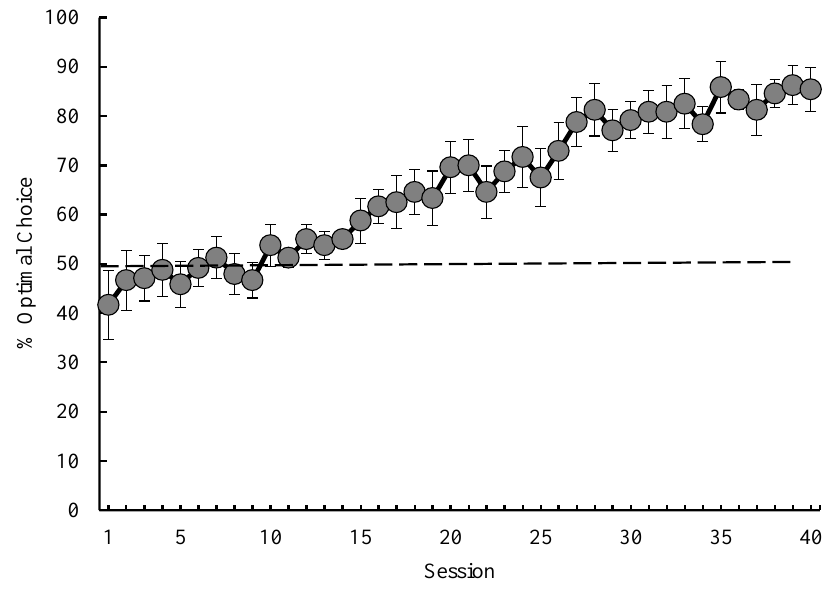
Figure 8 . Percentage optimal choice for rats that had to complete a fixed interval 20 s schedule (FI 20s) to obtain initial reinforcement (error bars = ±SEM; After Zentall et al., 2017b). Compare with the data presented in Figure